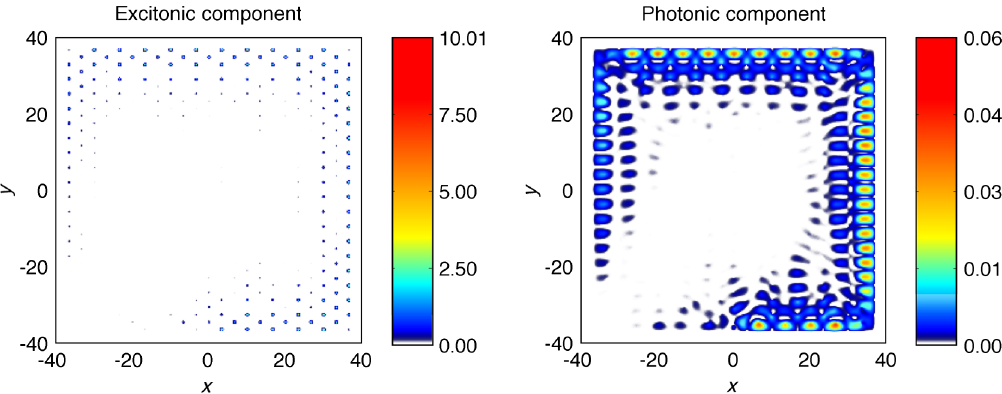
FIG. 7. Topolariton edge modes. The figure depicts the typical intensities of the exciton and photon fields obtained when pumping a finite square system optically at the center of its lower edge, shown here at time t ¼ 4 × 10 3 after switching on the laser for a triangular- ¼ − 0 . 05 and lattice constant a ¼ 3 . 86 . Units are defined here by setting ω X lattice exciton potential of strength V 0 and the speed of X ¼ 1 × 10 3 , g ¼ 0 . 1 , the pumping frequency ω ¼ 0 . 856 , and a polariton decay light to unity (other relevant parameters are m X q p rate γ ¼ 5 × 10 − 4 ). A counterclockwise chiral edge mode is clearly visible, with an exciton component strongly peaked at the minima of the periodic potential. Exciton and photon fields both travel together as a unique polaritonic chiral edge